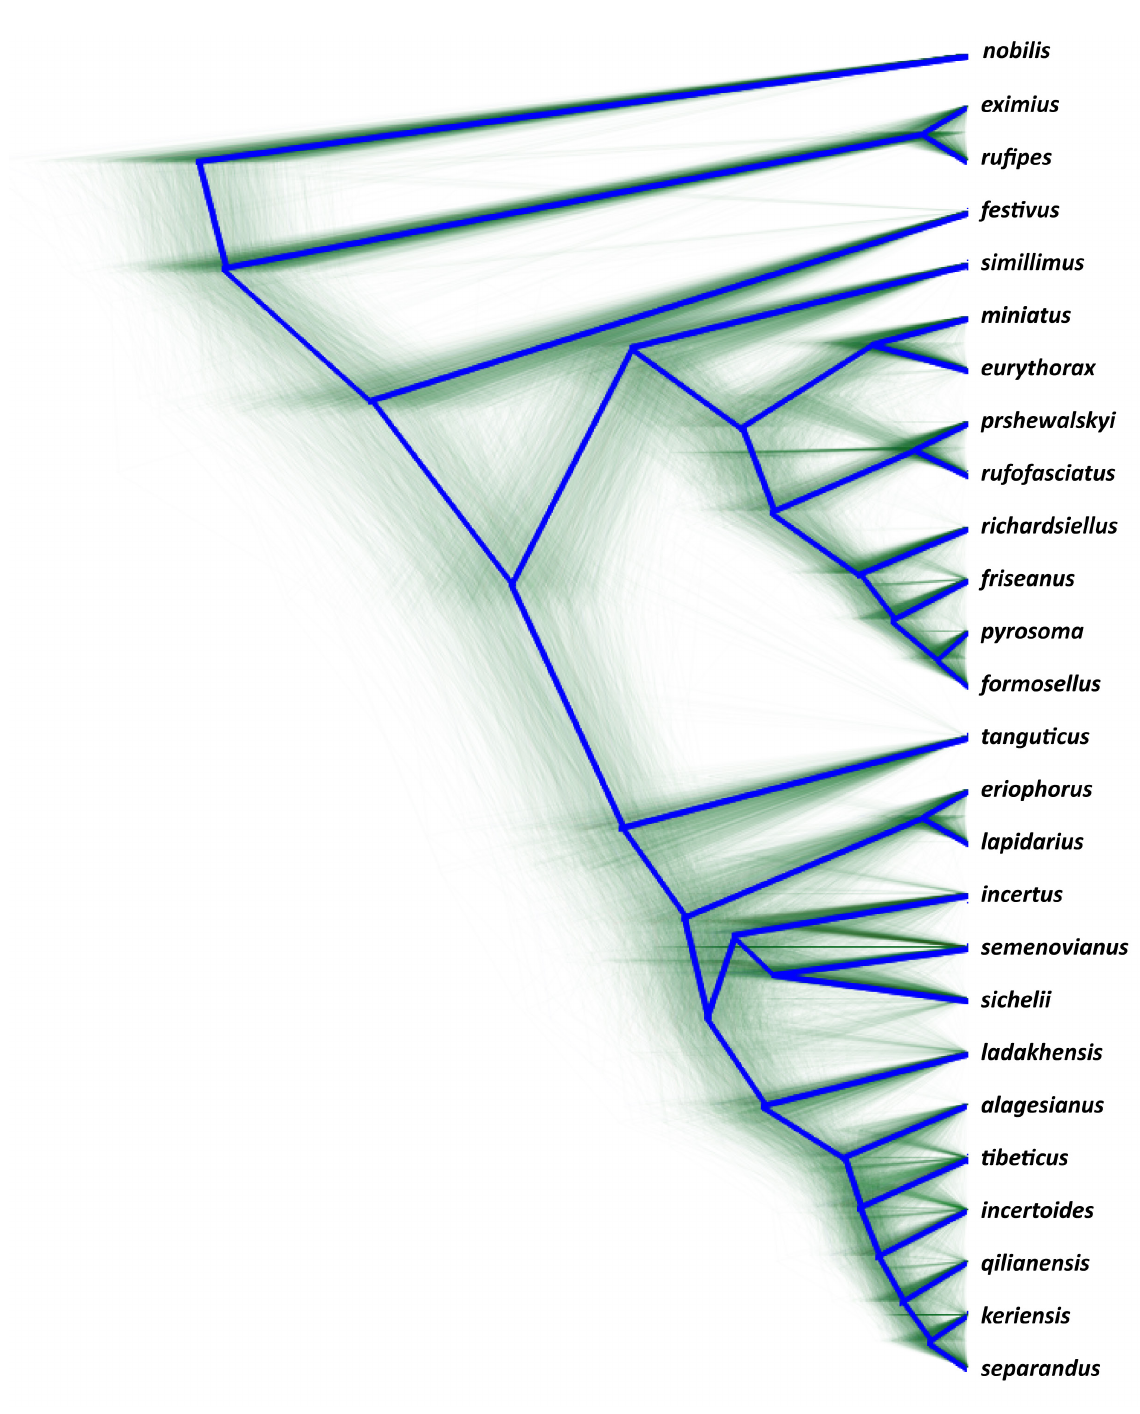
Fig. 21. A sample of 10 000 species trees from among 100 million trees for species of the subgenus Melanobombus von Dalla Torre, 1880 reconstructed with *BEAST from gene trees for the COI, 16S, opsin and PEPCK genes, displayed in green using Densitree, with the summary ‘root canal’ superimposed as a thick blue line. The outgroup B. nobilis Friese, 1905 is